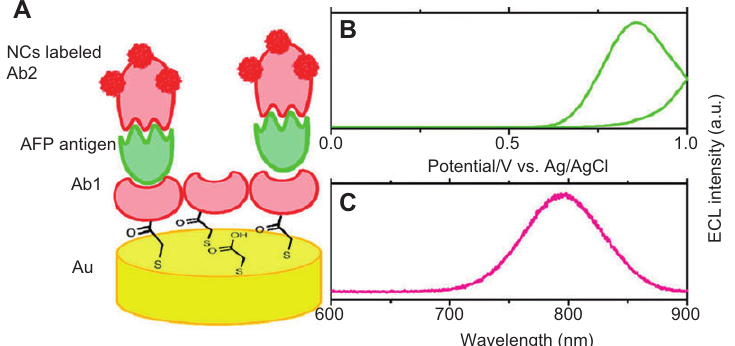
Figure 5 (A) Schematic representation of NIR sandwich-typed immunoassay. (B) ECL-potential curves and (C) ECL spectrum of Au/TGA/Ab1- Ag-Ab2-NCs in 0.10 m pH 9.2 PBS containing 20.0 m m DBAE at a scan rate of 100 mV/s. Ag concentration: 40.0 ng/ml. (Reproduced with permission from ACS